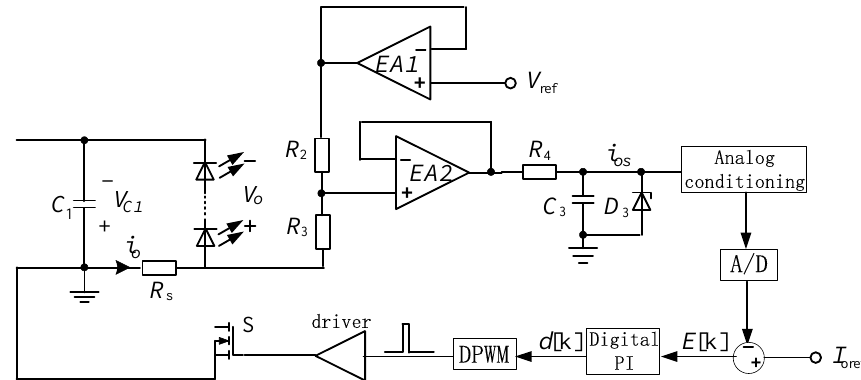
Figure 8. Control block diagram of the proposed LED driver.